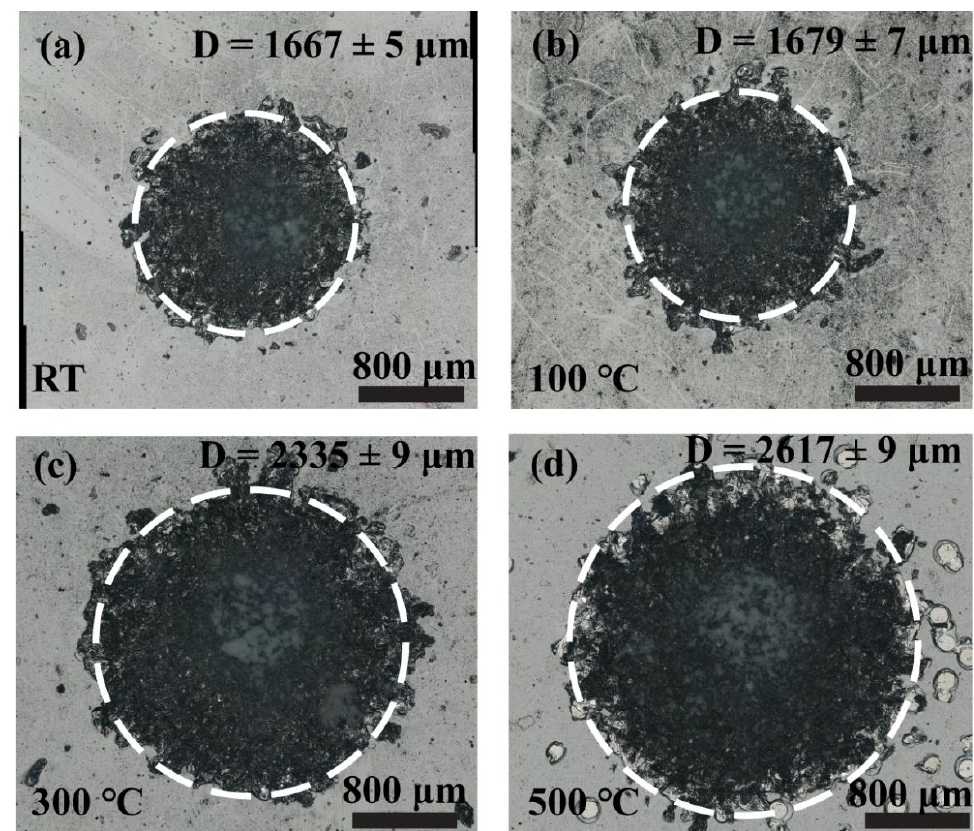
Figure 6. Surface topography of Cr/W-DLC/DLC multilayer films under the sand condition at ( a ) RT, ( b ) 100 °C, ( c ) 300 °C, and ( d ) 500 °C.